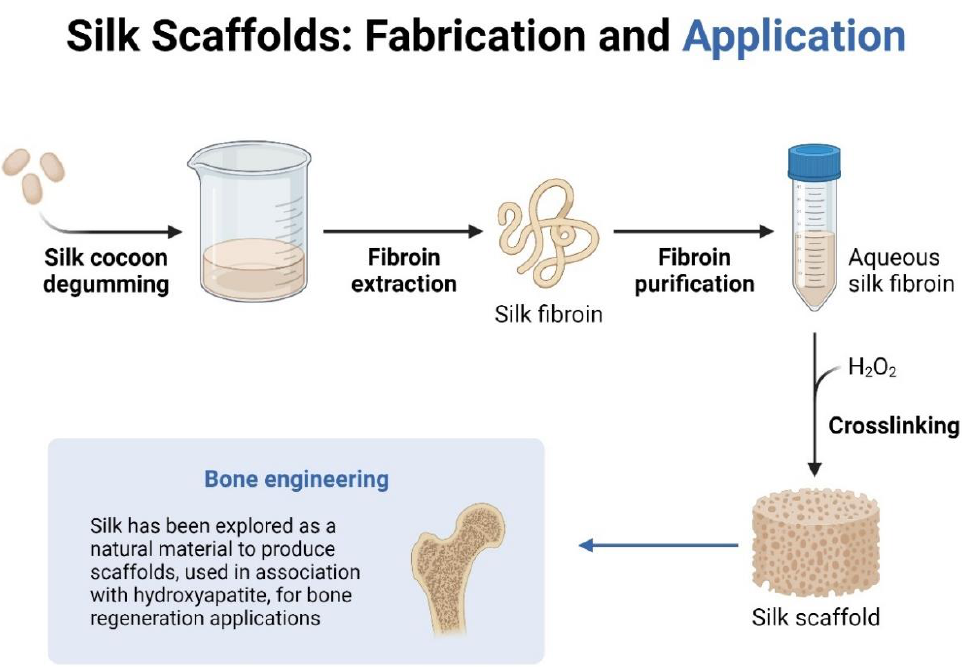
Figure Figure 3. Silk scaffolds, fabrications, and applications in bone engineering (image created in Bioren- der).